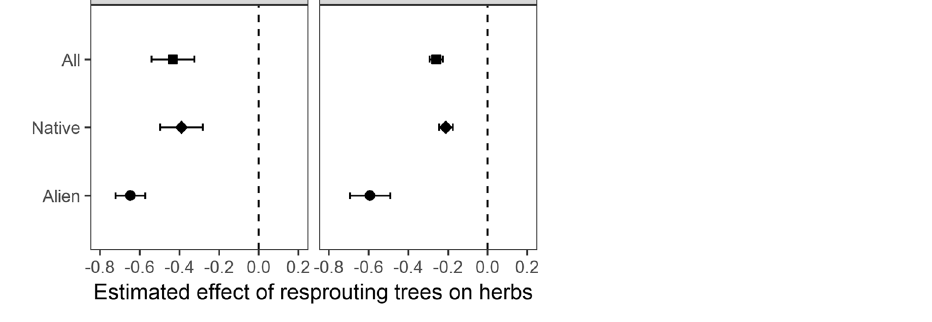
Figure 3. Estimated effects of resprouting trees (sprout biomass) on cover and species richness of all, alien and native plants. All variables were standardized to zero mean and unit variance. Points correspond to slope estimates and lines to 95% confidence intervals. Filled symbols indicate effects with P ≤